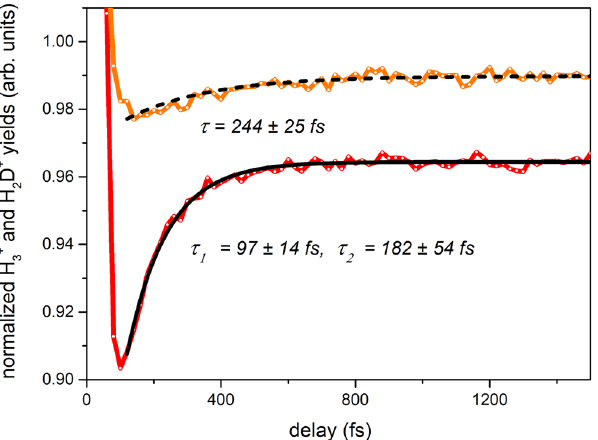
Figure 6. Normalized H 3 + (red solid line) and H 2 D + (orange solid line) yields from dissociative ionization of CH 3 OD as a function of pump-probe delay. Normalization was performed with respect to the yields at negative time delays (see Fig. 5). Exponential fits corresponding to the H 3 + and H 2 D + yields are shown by black solid and dashed lines, respectively.